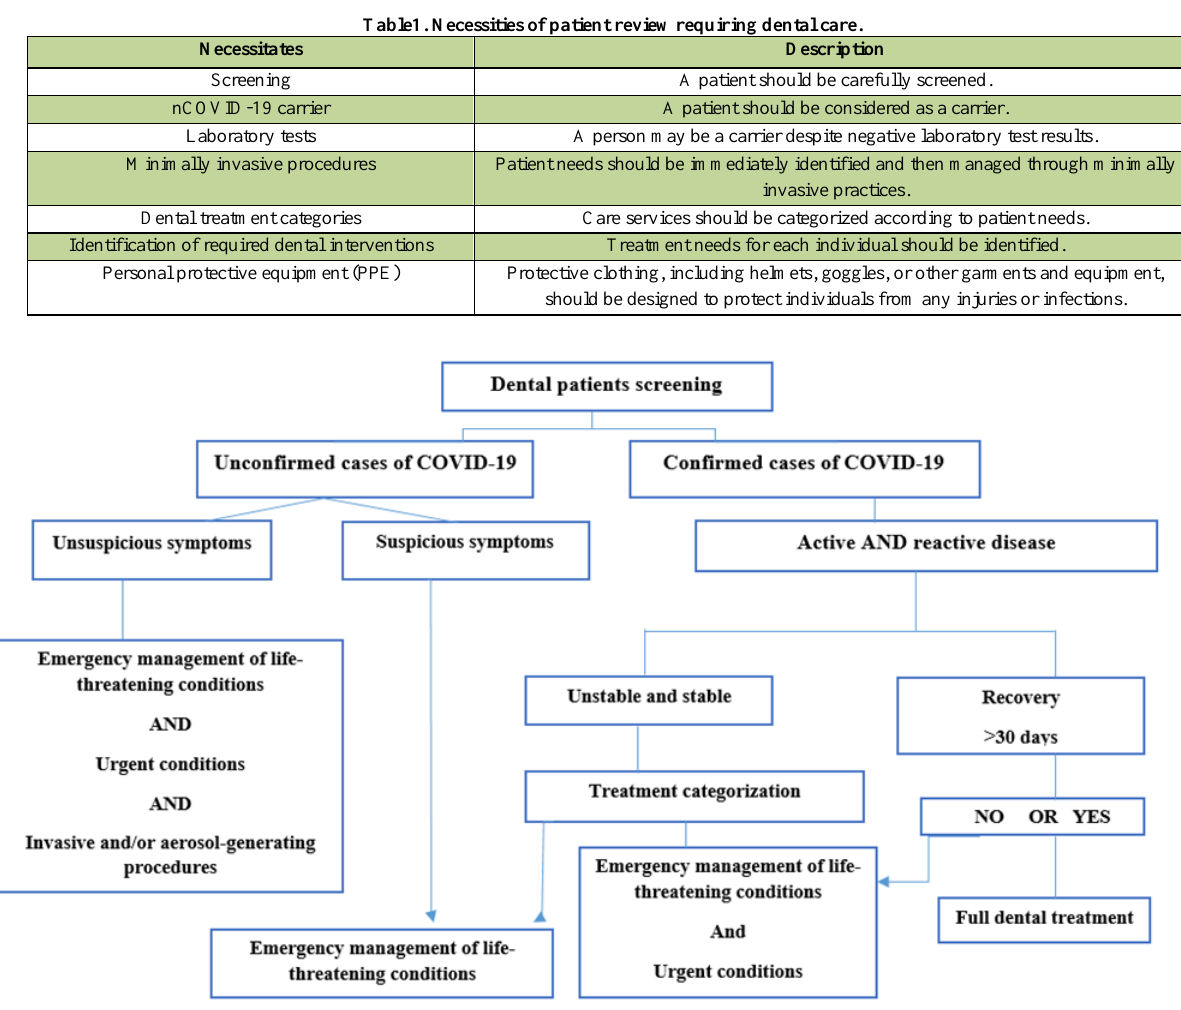
Figure 1. Dental patients screening of epidemic period of